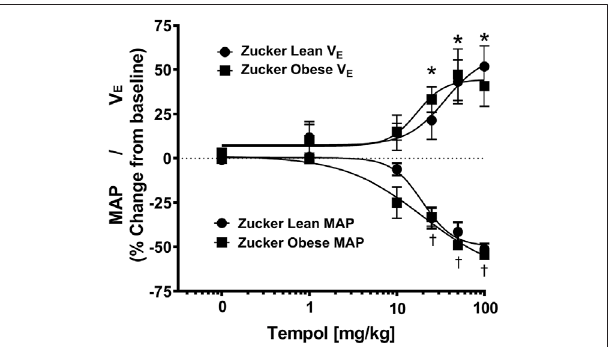
FIGURE 5 | Tempol elicited dose-dependent increases in minute ventilation and decreases in mean arterial blood pressure (MAP) that were similar in magnitude in obese and lean Zucker rats. The maximum changes in minute ventilation ( Y -axis, positive Y values, 0 – 75) and MAP ( Y -axis, negative Y values, 0 – 75) elicited by cumulative doses of Tempol (1 – 100 mg/kg, IV) in lean (circle) and obese (square) Zucker rats. Nonlinear regression analysis was performed to identify the ED 50 values for minute ventilation and MAP in lean and obese Zucker rats. Comparable ED 50 values for MAP was obtained for lean (19.8 mg/kg) and obese (20.0 mg/kg) Zucker rats. In contrast, ED 50 values for minute ventilation in obese Zucker rats (15.3 mg/kg) were lower than in the lean Zucker rats (35.9 mg/kg). The values are presented as mean ± SEM. There were six rats in each group. * p < .05, minute ventilation signi fi cant change from baseline. † p < .05, MAP signi fi cant change from baseline.